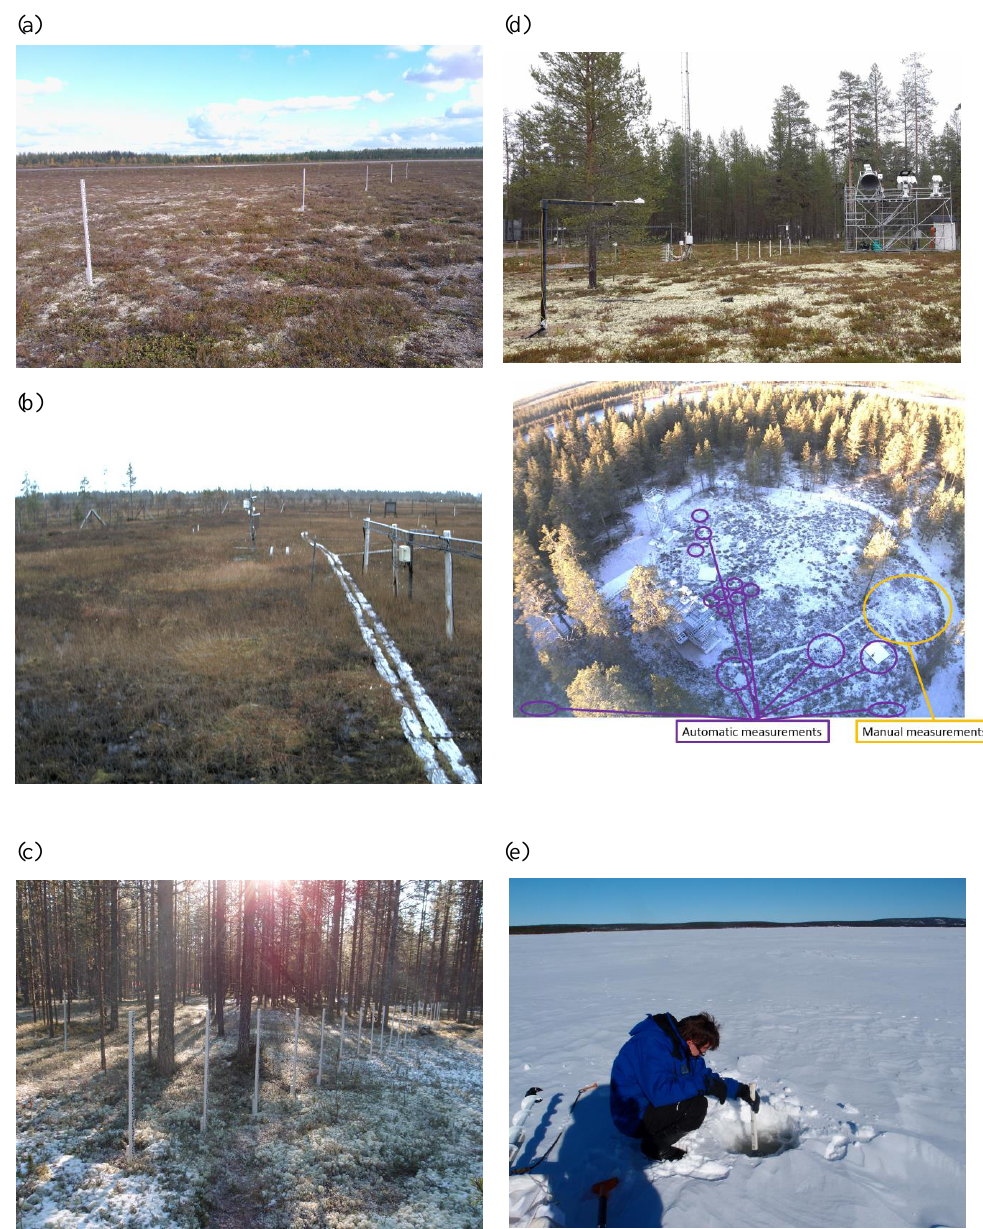
Figure 2. Snow measurement sites: (a) airport, (b) bog site, (c) forest site, (d) IOA, (e) Lake